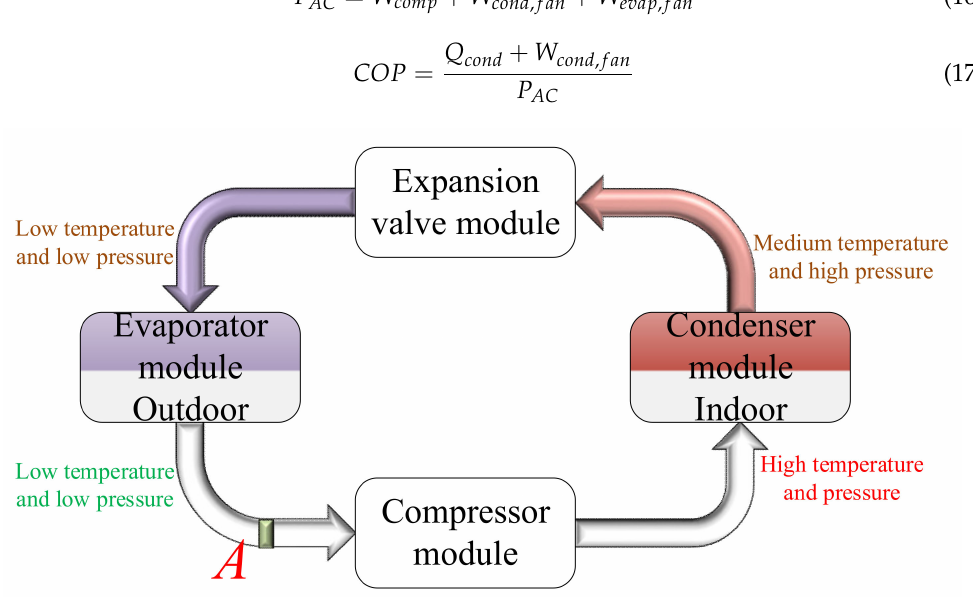
Figure 3. Schematic diagram of AC heating